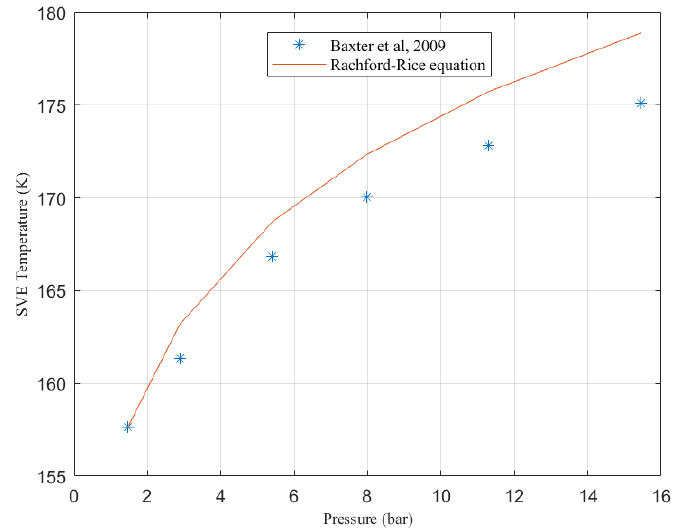
Figure 5. Comparison of calculated SVE temperature using the Rachford–Rice model against the proposed approach in [18].